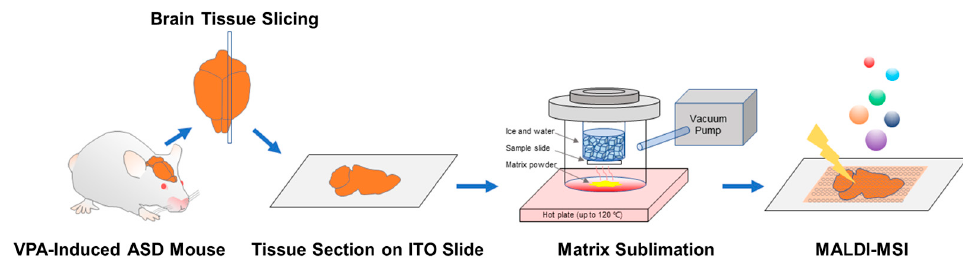
Figure 1. Matrix-assisted laser desorption/ionization mass spectrometry imaging (MALDI-MSI) workflow for autism spectrum disorder (ASD) mouse brain tissues. The brains of valproic acid- induced ASD mice were removed, and the brain tissue was cut to a thickness of 12 μ m and attached to an ITO slide by thaw-mounting. After sufficiently drying the tissue sections, 1,5-diaminonaphthalene was sublimated on the sample. MALDI-MSI was performed by irradiating whole tissue sections with a laser beam focused at 50 μ m and recording the ion signals produced.